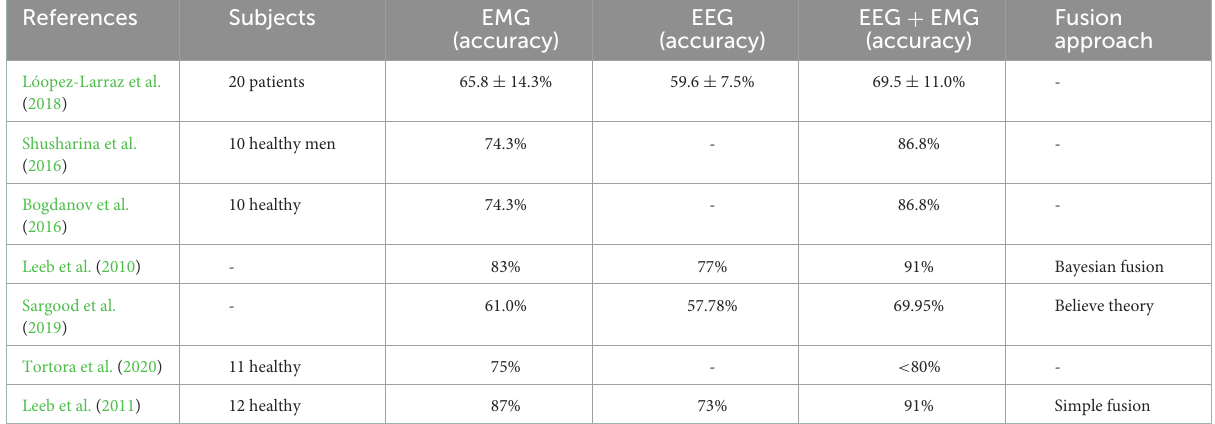
TABLE 3 Summary of EEG and EMG recognition accuracy after various fusion